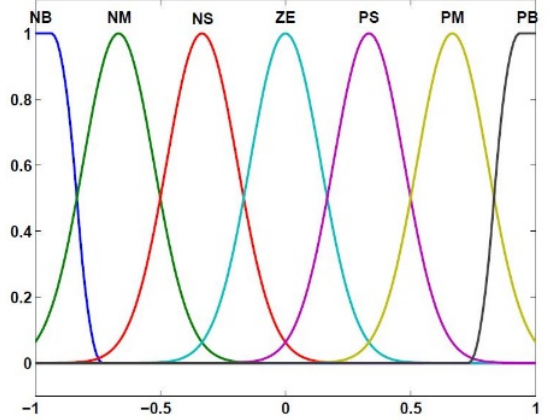
Figure 3. Membership functions of input and output variables.